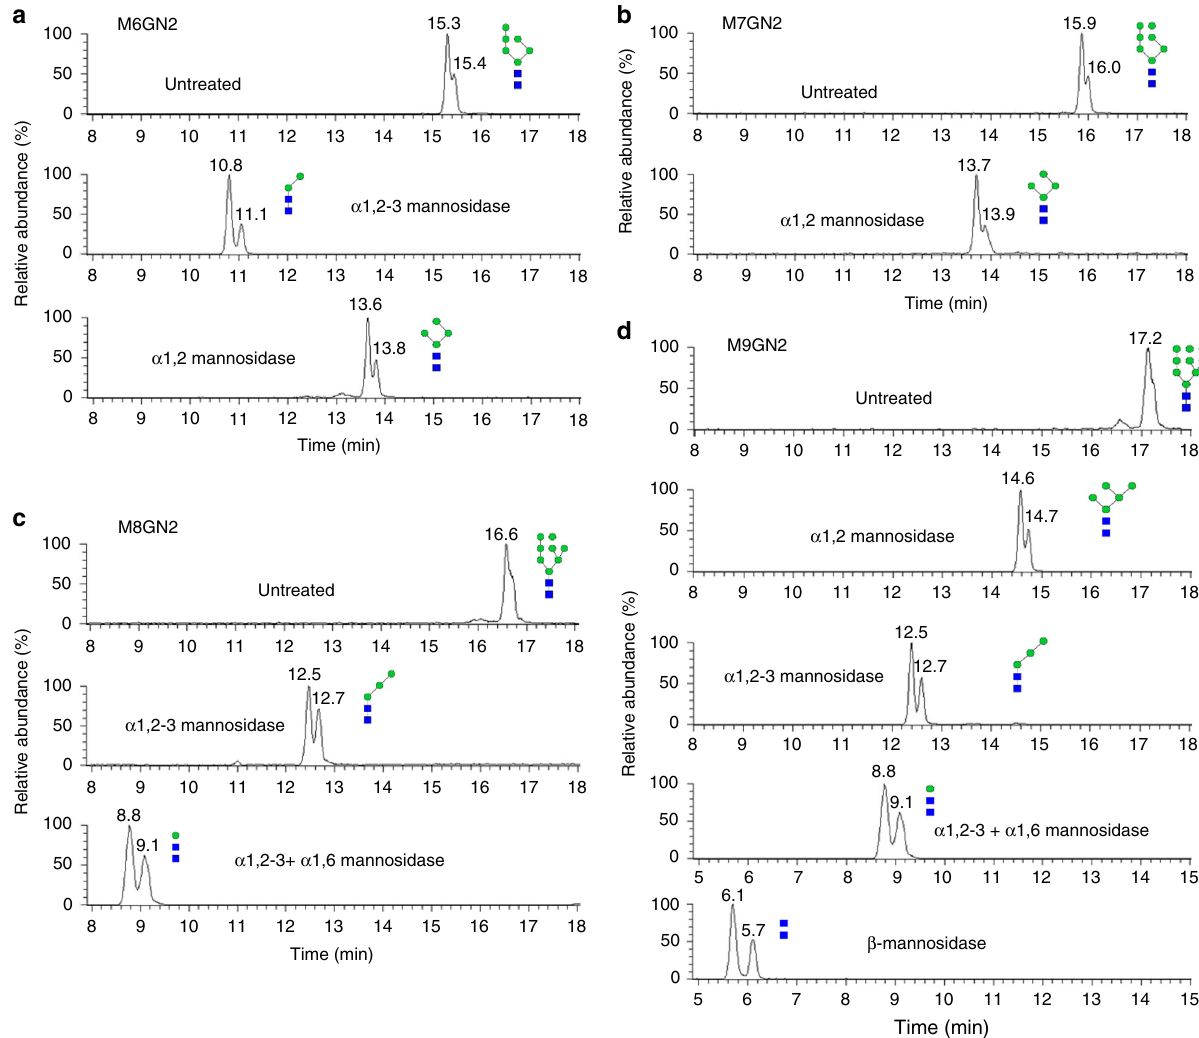
Fig. 4 UPLC – MS analyses of mannosidase digestion of M9GN2 and precursors. Each of the glycans generated in experiments shown in Fig. 3b were digested with linkage-speci fi c mannosidases, including: α 1,2-mannosidase, which removes terminal α 1,2 mannoses; α 1,2-3-mannosidase, which removes terminal α 1,2 mannoses and terminal α 1,3 mannoses; α 1,6-mannosidase, which removes terminal non-branched α 1,6 mannoses; β -mannosidase, which